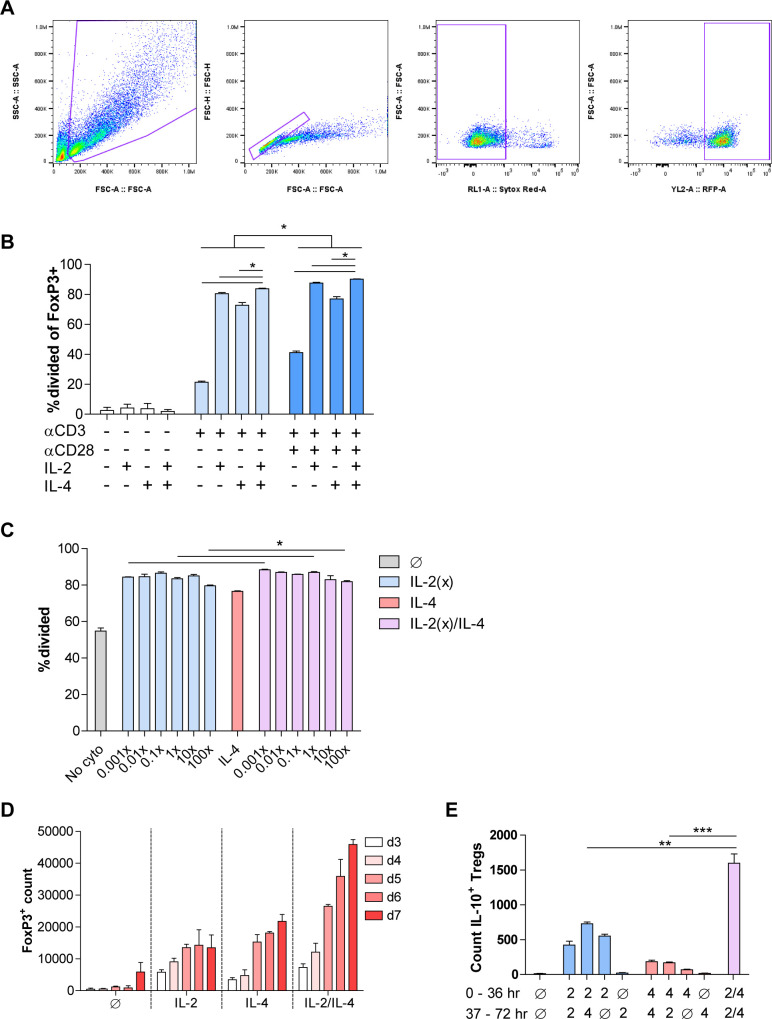
Dosing and time-dependency of combinatorial cytokine stimulation on Treg proliferation.(A) Flow cytometry gating schematic for FoxP3+ Treg proliferation analyses. Cells are first gated on FSC-A and SSC-A, then a single cell gate made on FSC-A and FSC-H. Sytox red negative events represent live cells, and then FoxP3-RFP positive events are gated. (B) Proliferation of Tregs stimulated for 3 days with the indicated T cell receptor, co-stim, and cytokine conditions, analyzed by flow cytometry. (C) Analysis of cellular division of Tregs stimulated for 3 days with the indicated cytokines while titrating IL-2 and analyzed by flow cytometry. 1× IL-2 = 728 pM. (D) Treg count following culture with αCD3ε and combined IL-2/IL-4 for 3–7 days, as analyzed by flow cytometry. Related to Figure 2I. (E) Enumeration of purified Tregs that underwent stimulation with αCD3ε and all cytokine combinations for 36 hr in culture with the first stimulation conditions, and another 36 hr with the second stimulation conditions after washing. Cells underwent flow cytometry. N = 3. For all panels, mean ± SEM are indicated. *p<0.05, **p<0.01, ***p<0.001, ****p<0.0001.